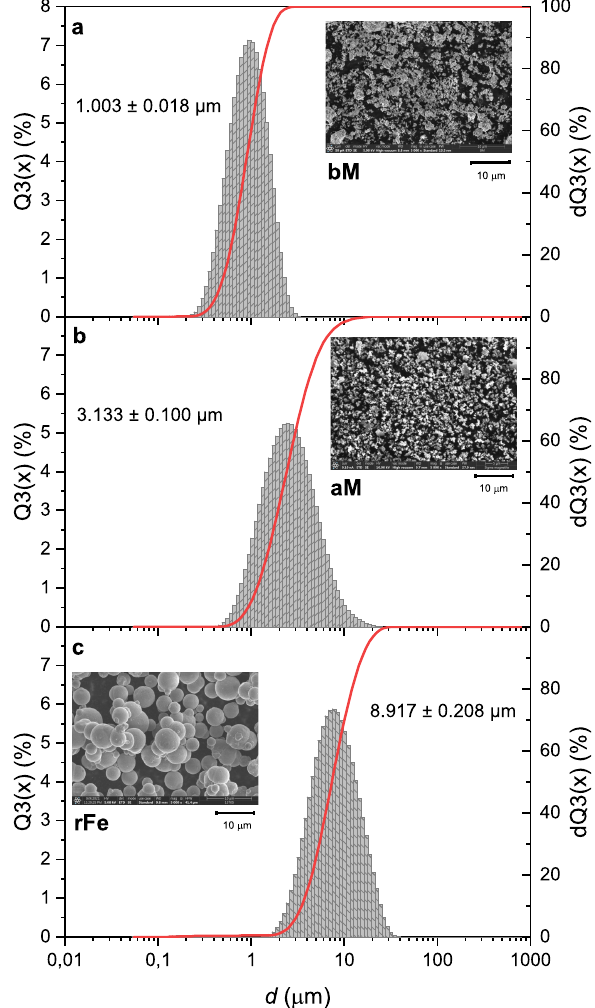
Figure 3. Particle size distribution of the bM magnetite ( a ), aM magnetite ( b ), and the rFe iron ( c ) filler materials measured with laser diffraction method. Columns represent the distribution density (Q3(x) in %) and the solid lines represent the cumulative distribution (dQ3(x) in %). The inset pictures show the morphology of the fillers according the SEM